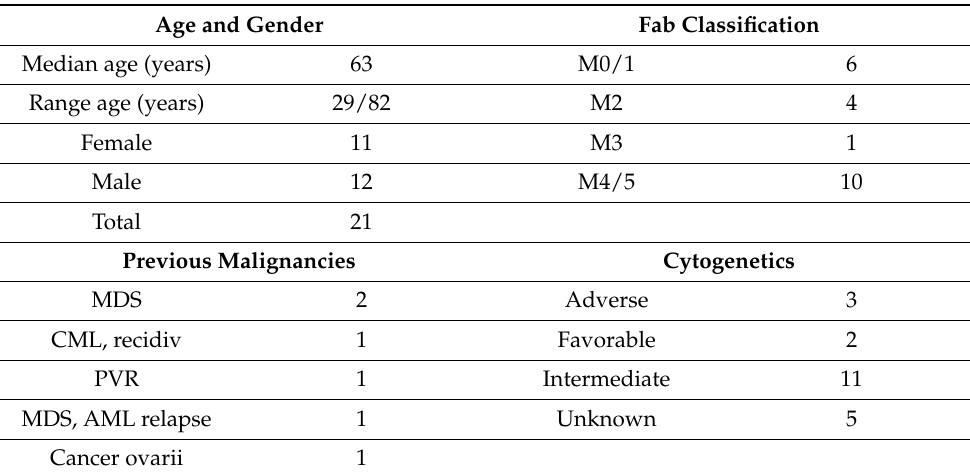
Table 1. Acute myeloid leukemia (AML) patient characteristics (in vitro valproic acid (VPA) re- sponse